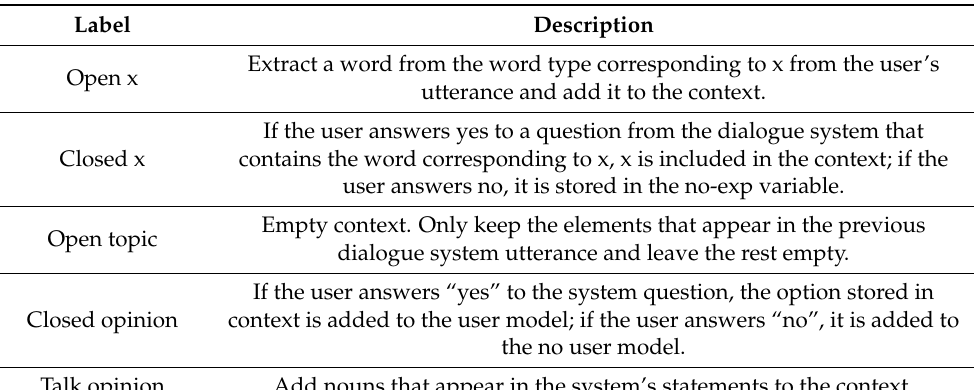
Table 3. Types of utterance and perlocutionary